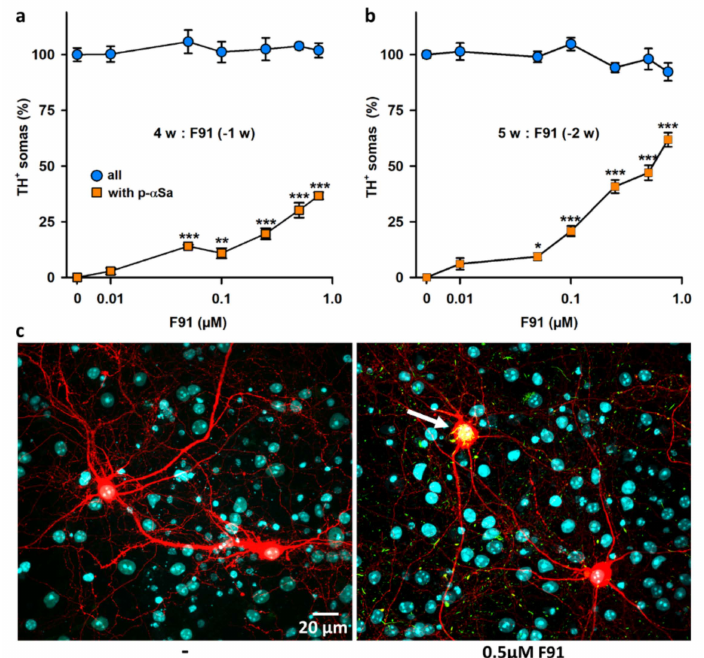
Figure 3. Impact of culture age on α S seeded aggregation in midbrain cultured DA neurons. ( a ) Percentage of DA (TH + ) cell somas with α Sa and survival of these neurons in four-week midbrain cultures exposed 1 week earlier ( − 1 w) to increasing concentrations of F91 (0.01–0.75 µ M). ( b ) Same parameters as in ( a ) in five-week midbrain cultures exposed two weeks earlier ( − 2 w) to increasing concentrations of F91 (0.01–0.75 µ M). Data in ( a , b ) are means ± SEM (3–8). * p < 0.05, ** p < 0.01, and *** p < 0.001 vs. controls. One-way ANOVA followed by Dunnett’s test. ( c ) Representative confocal images of TH + neurons (red) in five-week midbrain cultures exposed or not exposed two weeks earlier to 0.5 µ M F91. The large p- α S inclusion pointed out by the white arrow in one of the two DA cell bodies in F91-treated cultures appears yellow after merging the green (p- α S) and red (TH) signals. Nuclei are counterstained with Hoechst 33,342